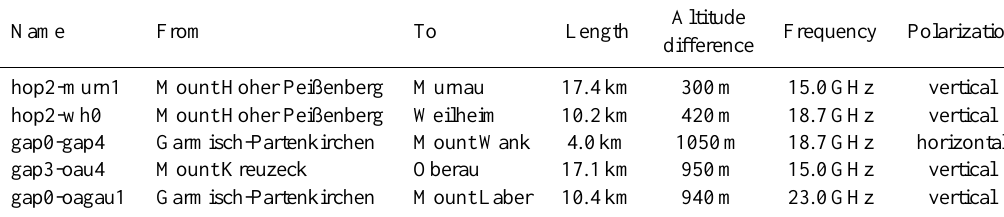
Table 1. Table of all links used in this study. Name From To Length